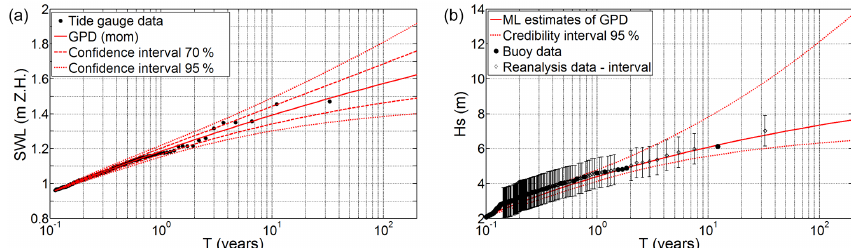
Figure 5. On the left, (a) GPD adjusted to the Sète tide gauge data. Threshold of the law is fixed at 0.96mZ.H. Parameters of the law are estimated using the method of moments. Confidence intervals are calculated by parametric bootstrap (Mazas and Hamm, 2011). On the right, (b) GPD law adjusted to H s data (Candhis et SCOT) by the HIBEVA method. The threshold is fixed at 2m. For illustration purposes, the SCOT data are presented by the central values of each